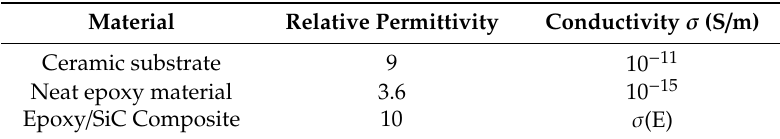
Figure 7. Simulation model. Table 8. Electrical parameters used in the simulation. Table 8. Electrical parameters used in the simulation.